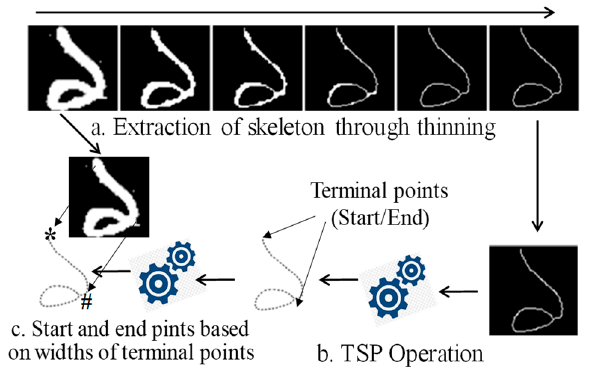
Figure 3. Demonstration of writing start (* marked) and end (# marked) points identification on a sample image.